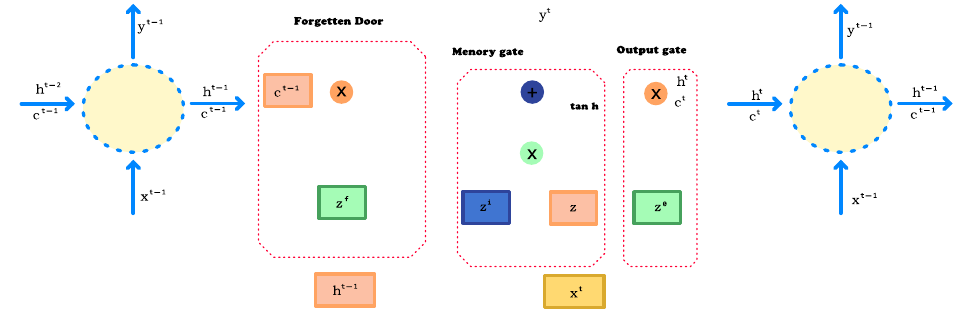
Figure 2. Schematic diagram of the LSTM